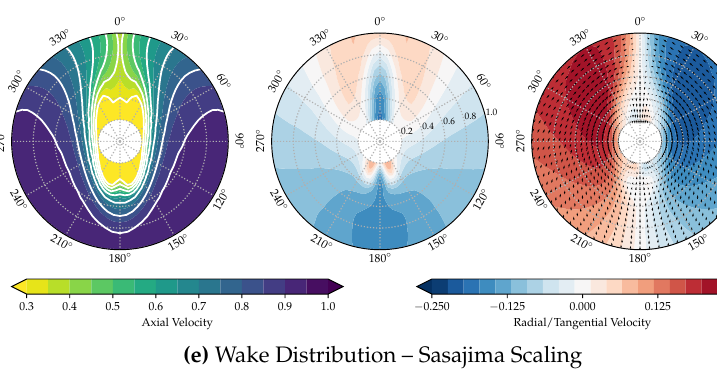
Figure 1. Wake fields for cavitation analysis, all scaled to w =